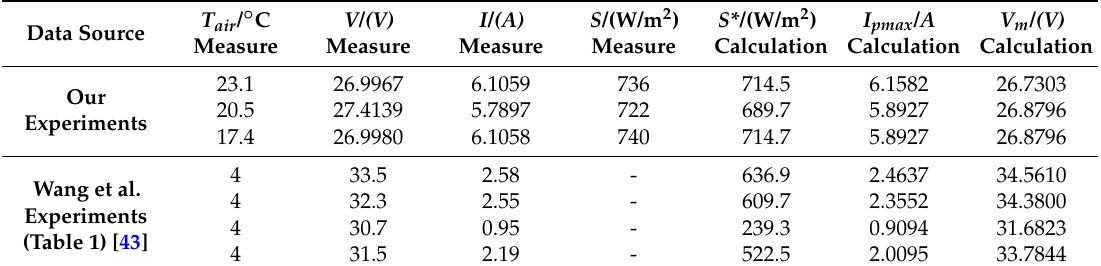
Table 3. Date of experimental measurement and